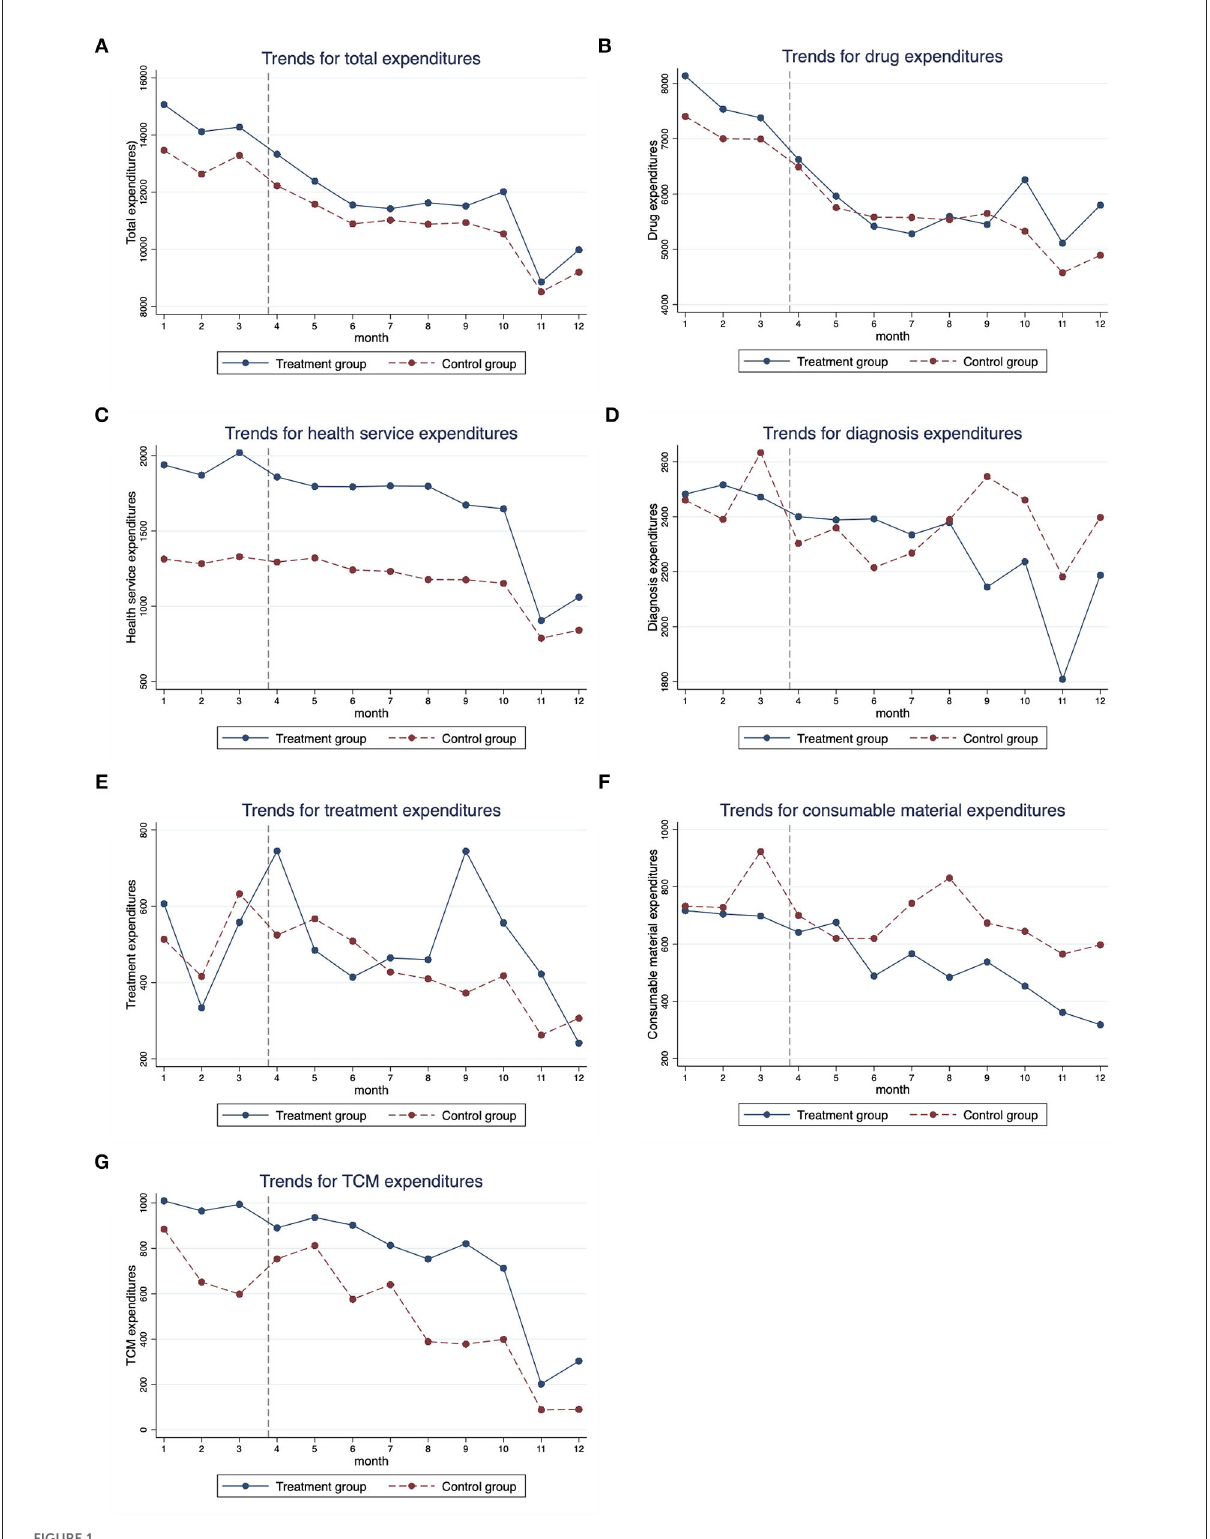
FIGURE1 Monthly trends for medical expenditures of cancer patients from January 2019 to December 2019. (A) Total expenditures, (B) drug expenditures, (C) health service expenditures, (D) diagnosis expenditures, (E) treatment expenditures, (F) consumable material expenditures, and (G) TCM